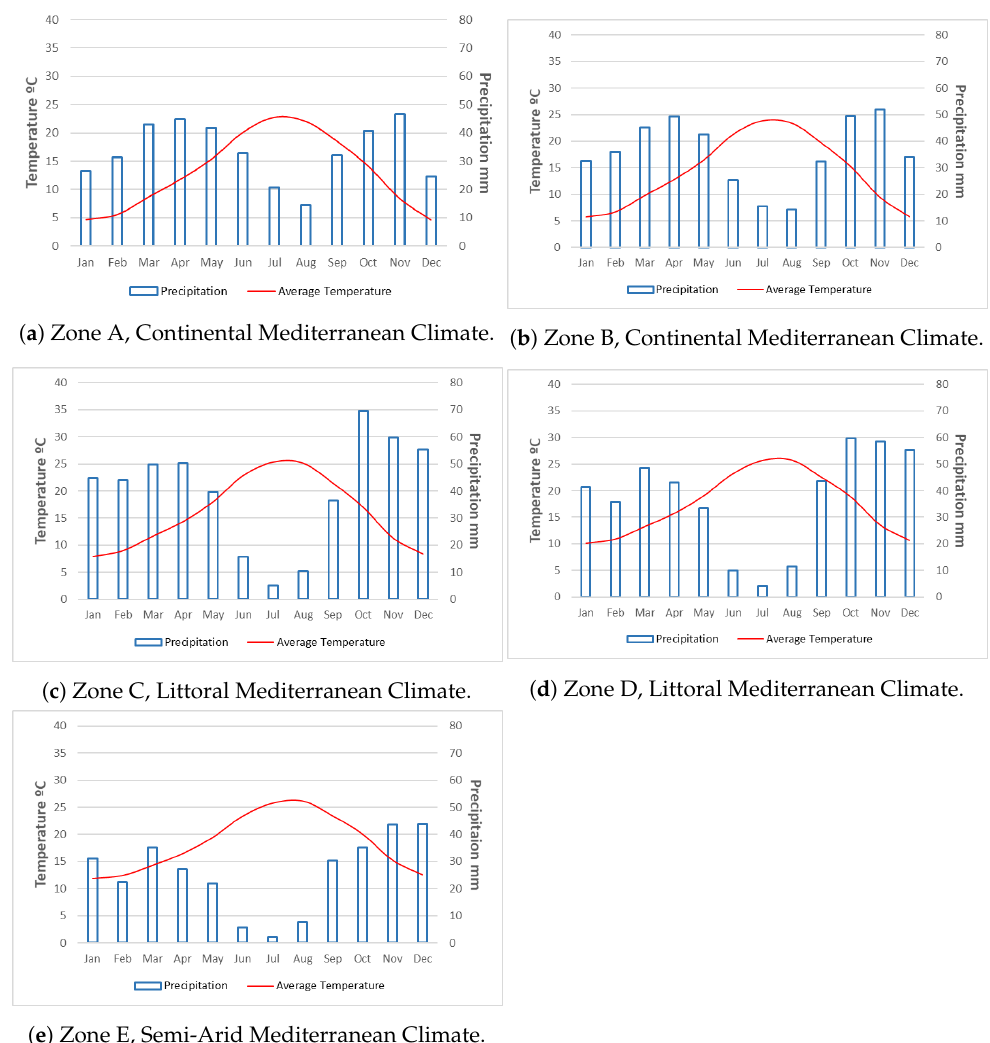
Figure 5. Ombrothermal diagrams for the five determined homoclimatic